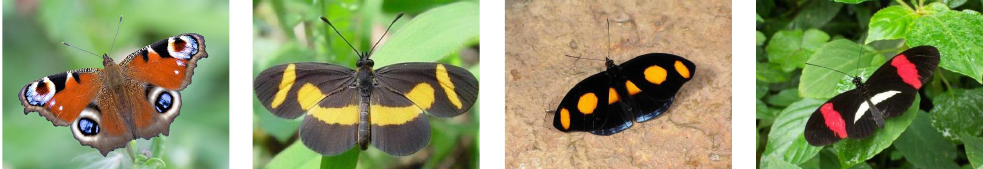
Figure 1. Some examples of symmetry on the wings of butterflies are clearly visible in the form of color patterns and